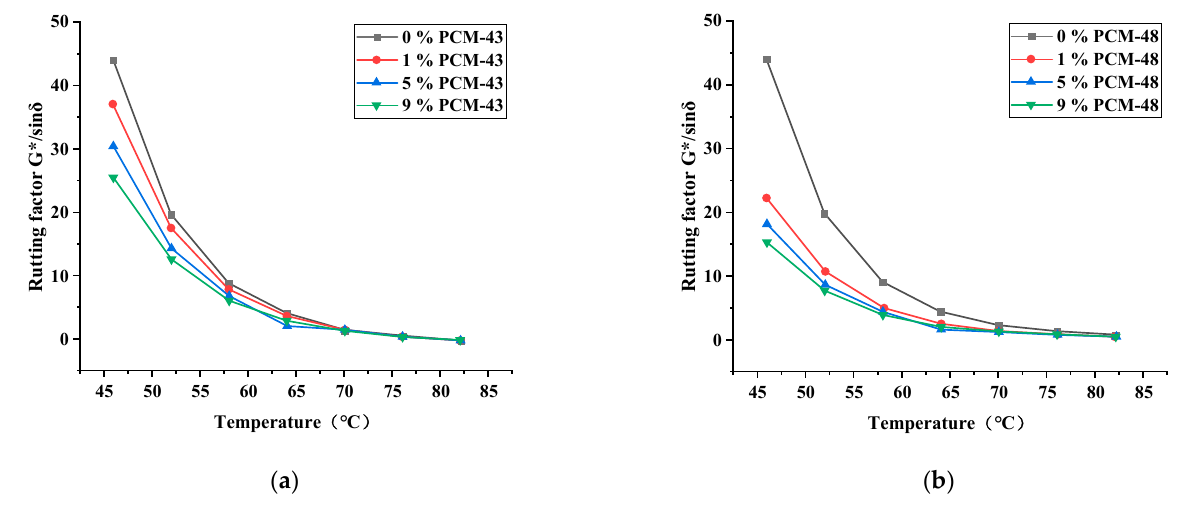
Figure 8 is the temperature adjustment effect diagram of asphalt mixed with PCM-